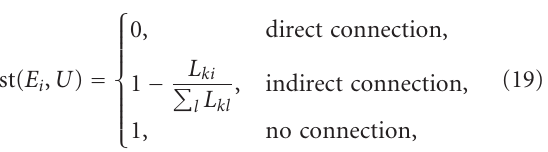
matching algorithm is applied to two sequences with obvious length di ff erence (multiple long shots vs. single event) in the shot-level sequence